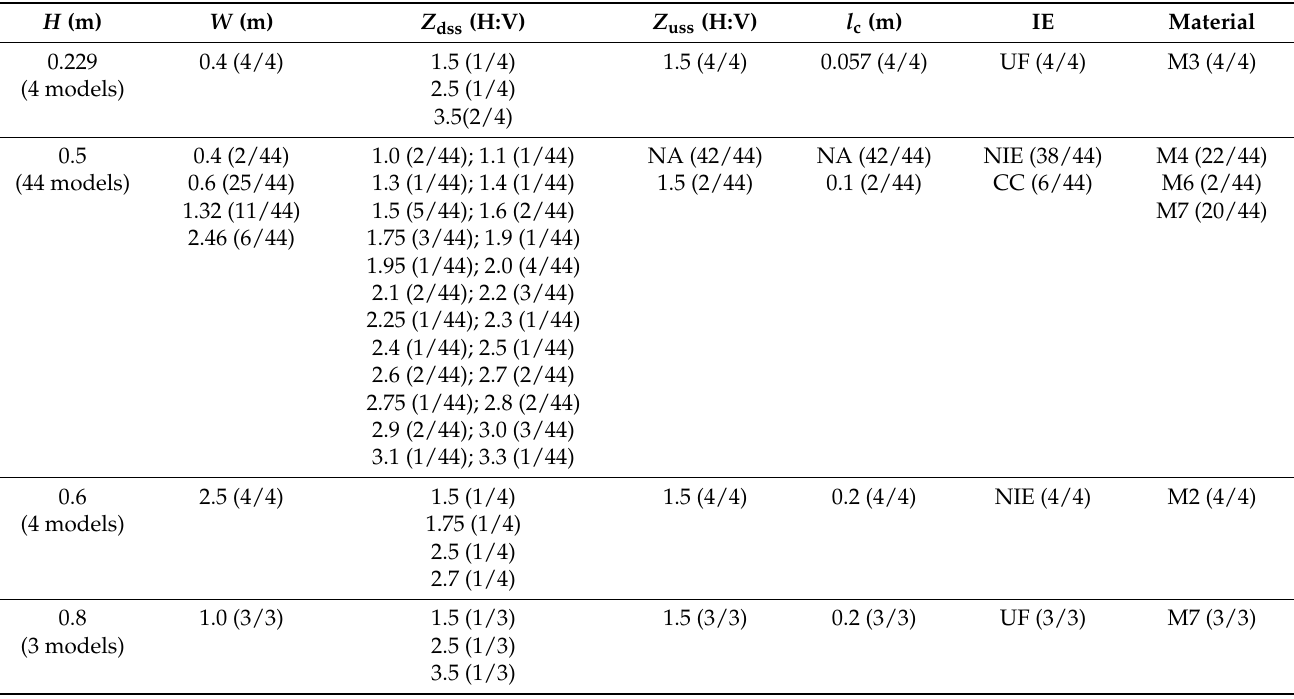
Table 1. Summary of the 114 physical models tested to study the failure of the rockfill downstream shoulder (values in parentheses represent the number of models tested for that particular configura- tion). NA means ‘not